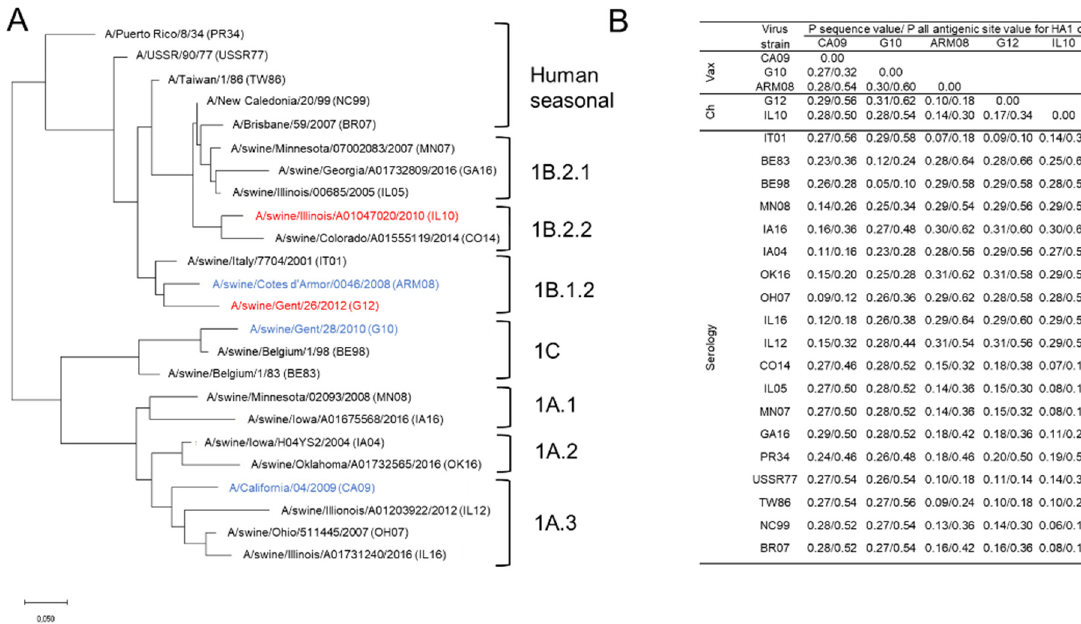
Figure 1. Genetic relationship between the influenza A virus strains included in the study. Maximum likelihood phylogenetic tree based on the hemagglutinin 1 (HA1) amino acid sequences ( A ) and P sequence values and P all antigenic site values for the HA1 ( B ) were determined for the influenza A virus strains used for vaccination (Vax) (blue), challenge (Ch) (red) and hemagglutination inhibition assays (serology). The H1 lineage is indicated: 1A, Classical swine lineage, 1B Human seasonal lineage, 1C Eurasian avian